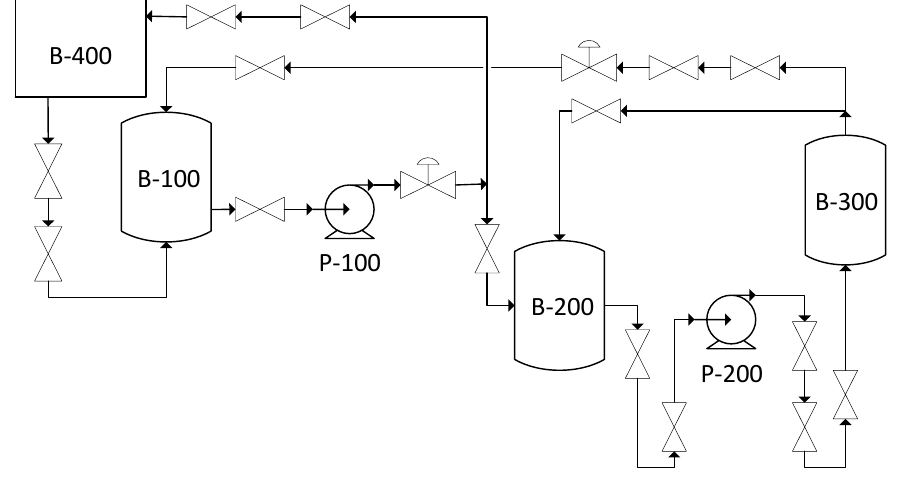
Figure 9. P&ID of the case process.